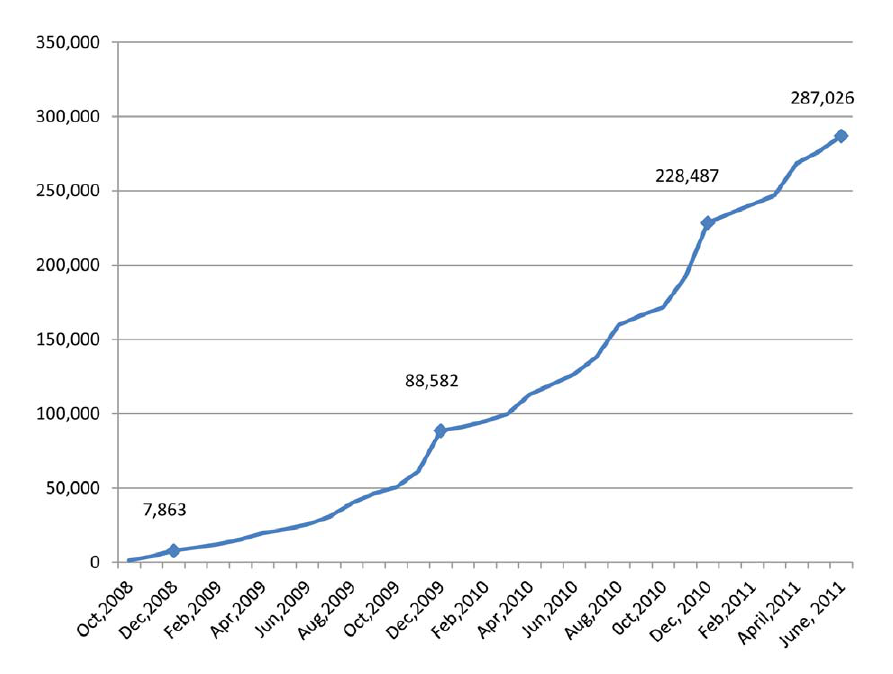
Figure 1. Cumulative circumcisions done in Kenya, 2008–2011.